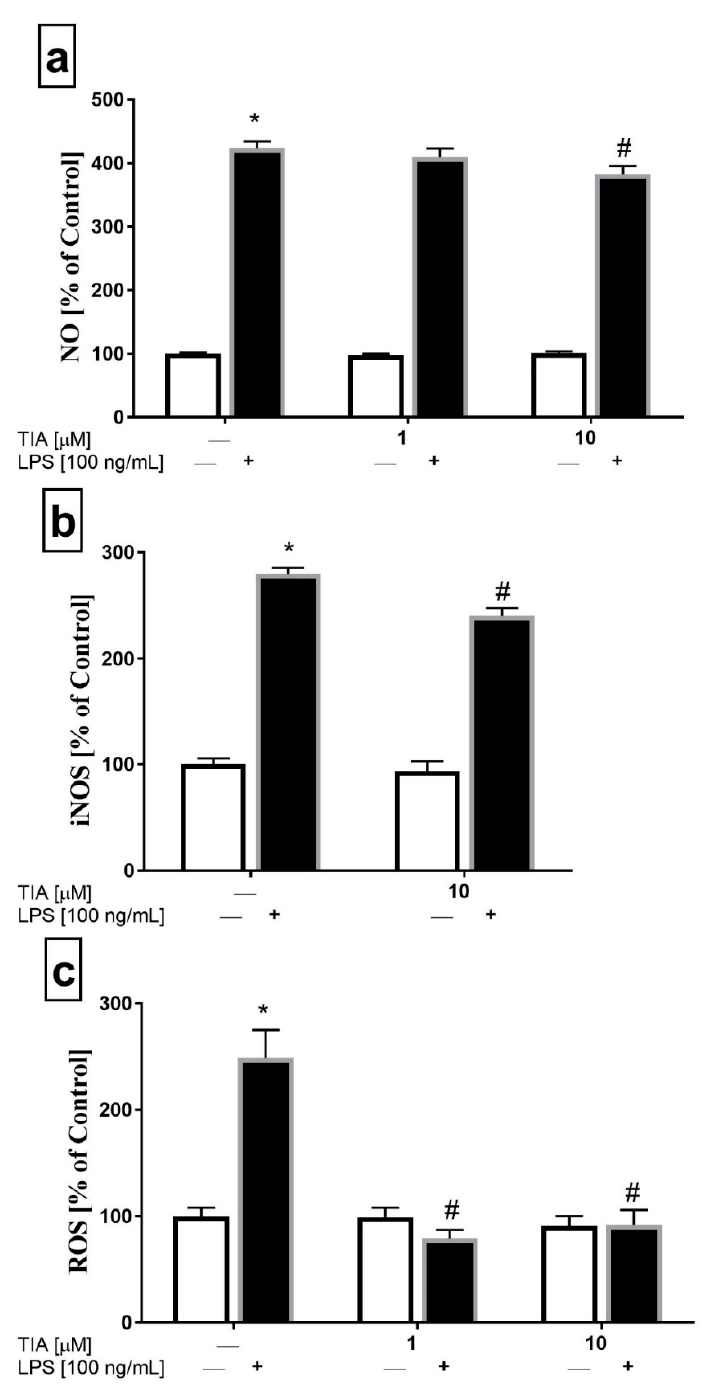
Figure 3. The effect of tianeptine (TIA) on nitric oxide (NO) release measured by the Griess reaction ( a ), the inducible nitric oxide synthase (iNOS) level ( b ) and the total intracellular reactive oxygen species (ROS) level ( c ) in vehicle- and LPS-treated primary microglial cells. Microglial cells were pretreated with tianeptine (TIA; 1 or 10 µ M) for 30 min, and then with lipopolysaccharide (LPS; 100 ng/mL) for 24 h. The data are presented as the mean ± SEM percentage of control (vehicle-treated cells) from independent experiments ( n = 6 in each group). The results were statistically evaluated using two-way analysis of variance (ANOVA) with a Duncan post-hoc test to assess the differences between the treatment groups. Significant differences from the control group (vehicle-treated cells) are indicated by * p < 0.05; differences between LPS-treated groups and pre-treated with tianeptine and then stimulated with LPS groups are indicated by # p <